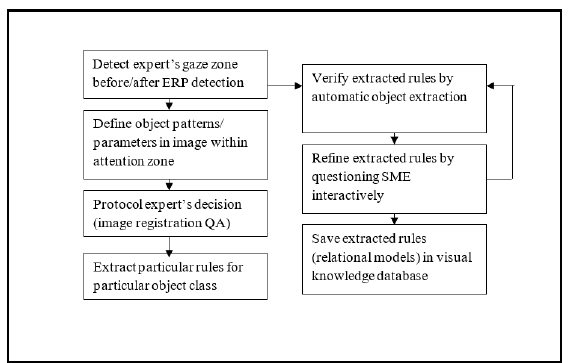
Figure 12. ERP - Visual attenuation Extraction